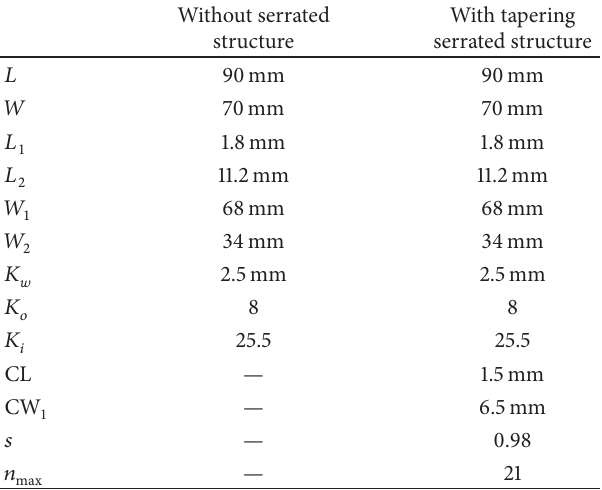
Table 1: Variables and dimensions of the designed